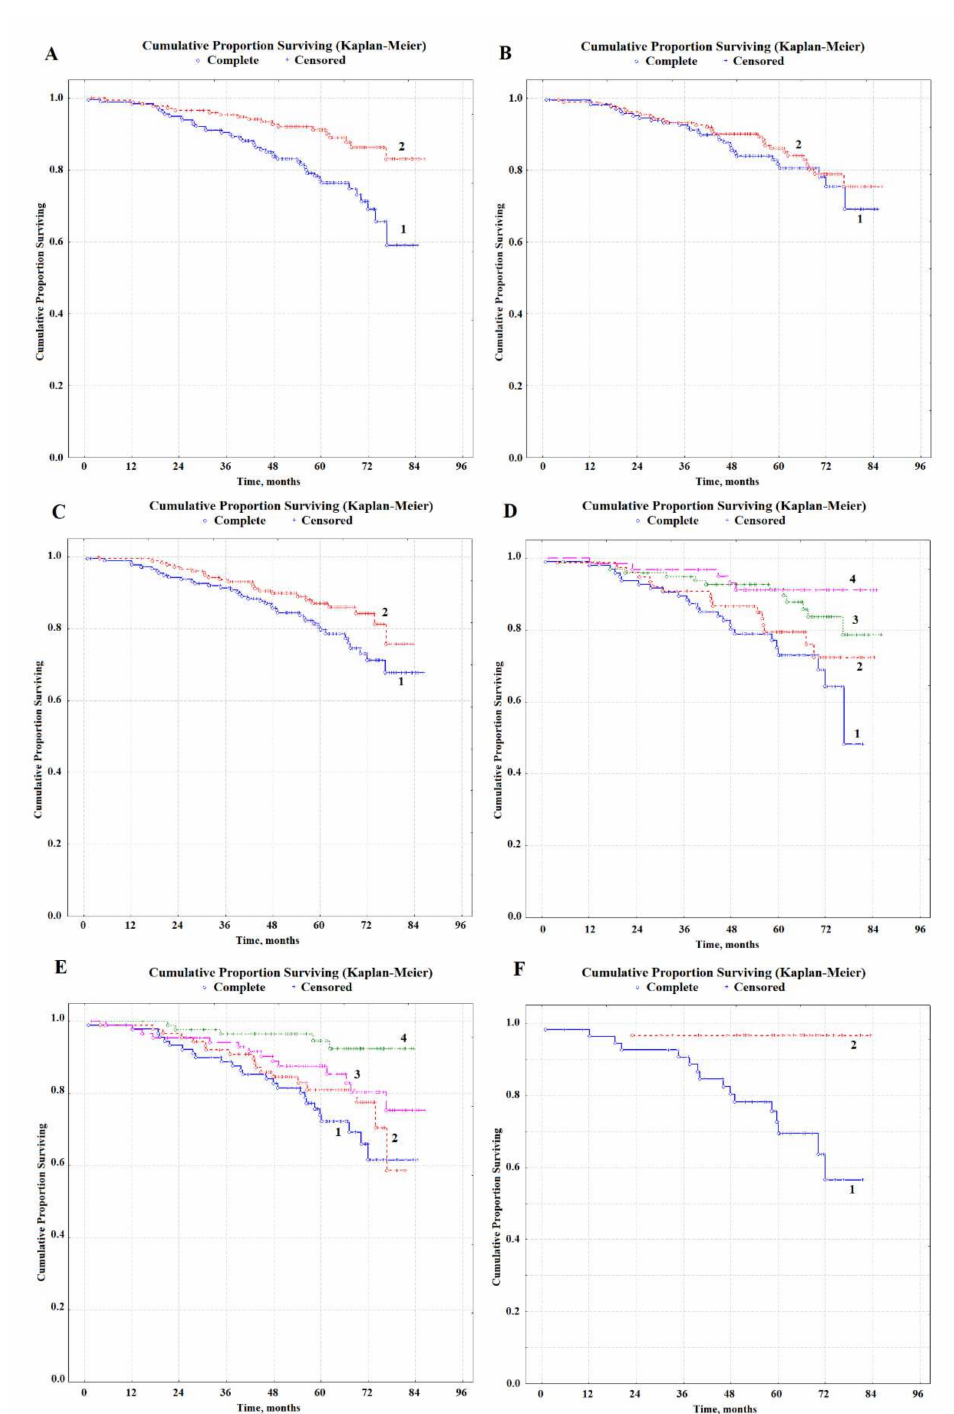
Figure 2. Overall survival of patients with primary resectable breast cancer depending on the biochem- ical composition of saliva before treatment: ( A ) unfavorable prognosis (curve 1, ALP < 71.7 U/L), favorable prognosis (curve 2, ALP > 71.7 U/L); ( B ) unfavorable prognosis (curve 1, AST > 6.33 U/L), favorable prognosis (curve 2, AST < 6.33 U/L); ( C ) unfavorable prognosis (curve 1, DC > 3.93 c.u.), favorable prognosis (curve 2, DC < 3.93 c.u.); ( D ) unfavorable prognosis (curve 1, ALP < 71.7